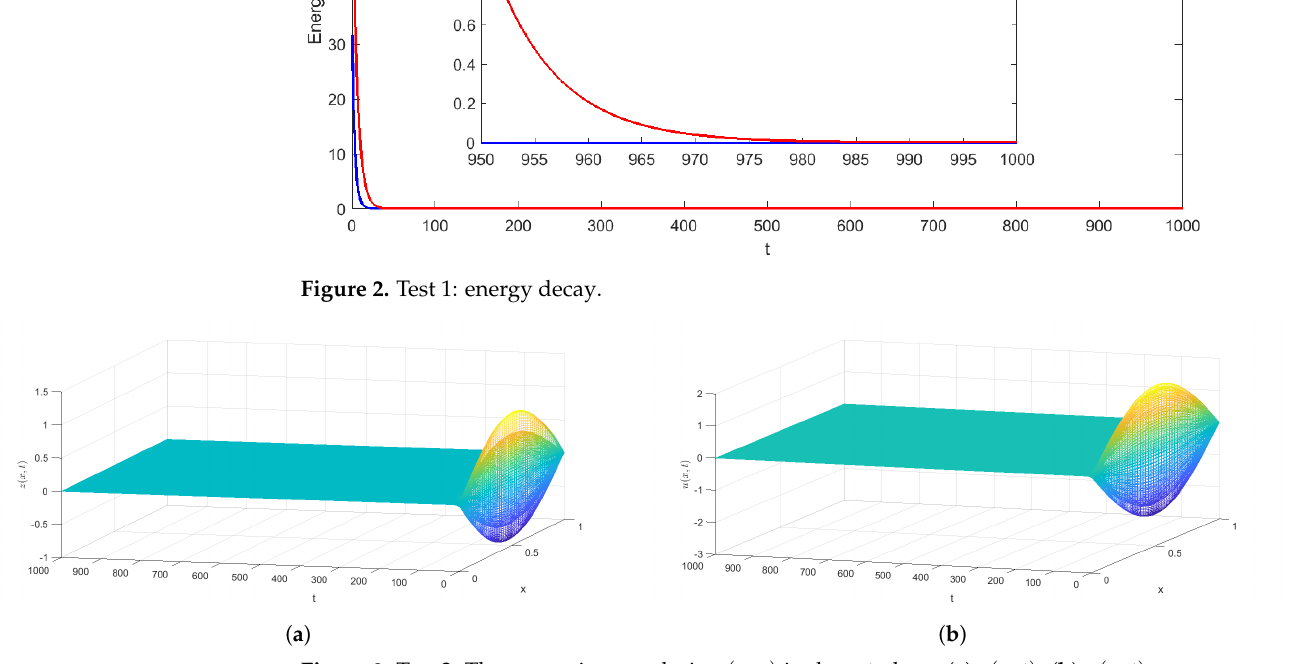
Figure 3. Test 2: The approximate solution ( z , u ) in the x - t plane. ( a ) z ( x , t ) . ( b ) u ( x , t ) .